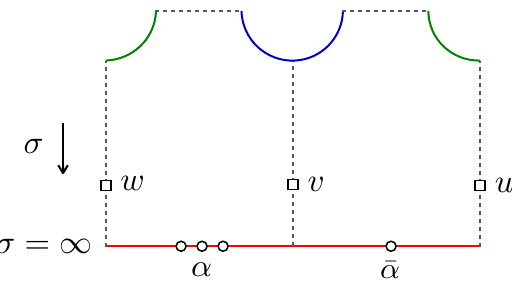
Figure 4 . We obtain an octagon by stitching two hexagons together along one mirror edge. We then consider the octagon transition between an incoming mirror magnon w in the far left and an outgoing mirror magnon u in the far right. This transition develops a simple pole at w = u , as soon as there is a mirror magnon v in the intermediate mirror channel to mediate the interaction from one hexagon to the other. This pole results from two basic facts: 1) an excitation traveling close to the bottom boundary decouples from the bulk of the geometry and moves freely, up to the di(cid:11)ractionless